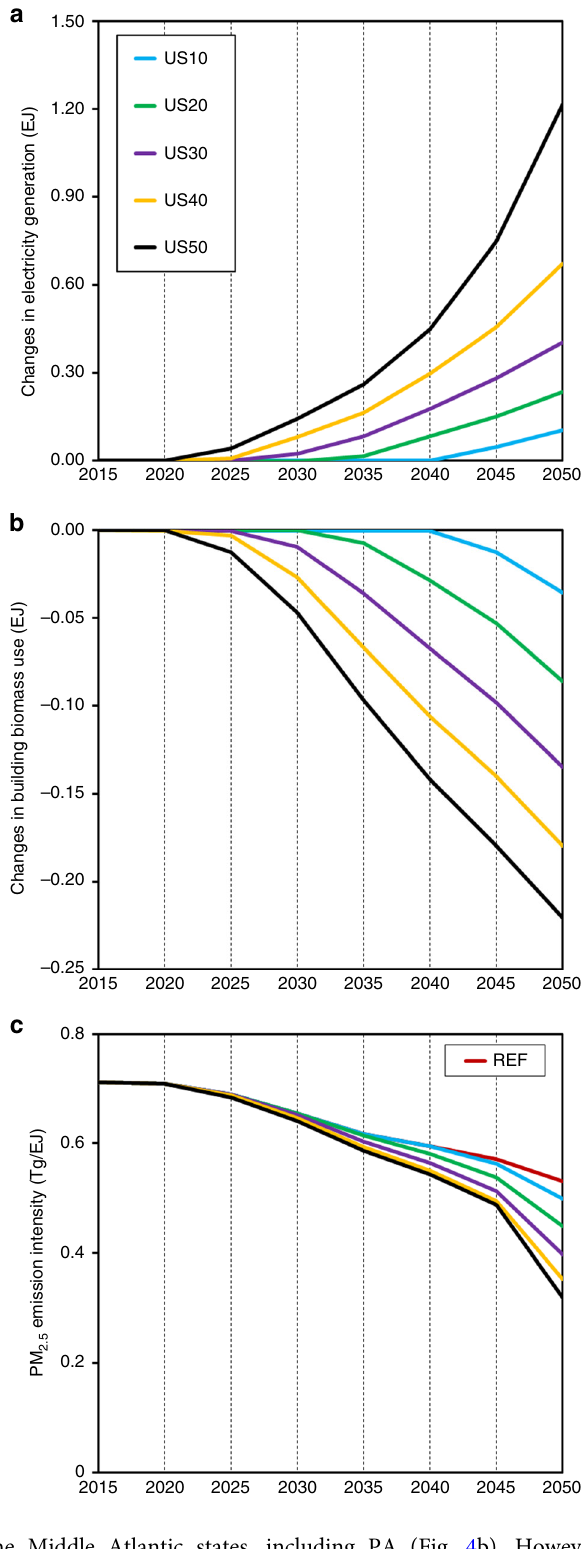
Fig. 3 Effects of PM 2.5 reduction stringency on technology replacement. Changes relative to REF for each modeling year for electricity generation (EJ) ( a ) and building biomass use (EJ) ( b ), and average PM 2.5 emission intensity (Tg EJ − 1 energy input) of building biomass ( c ). More stringent PM 2.5 -related mortality costs (PMMC) reductions expedite electri fi cation and the retirement of high- emission-intensity sources in end-use sectors. Emission intensity is also found to decrease for other major